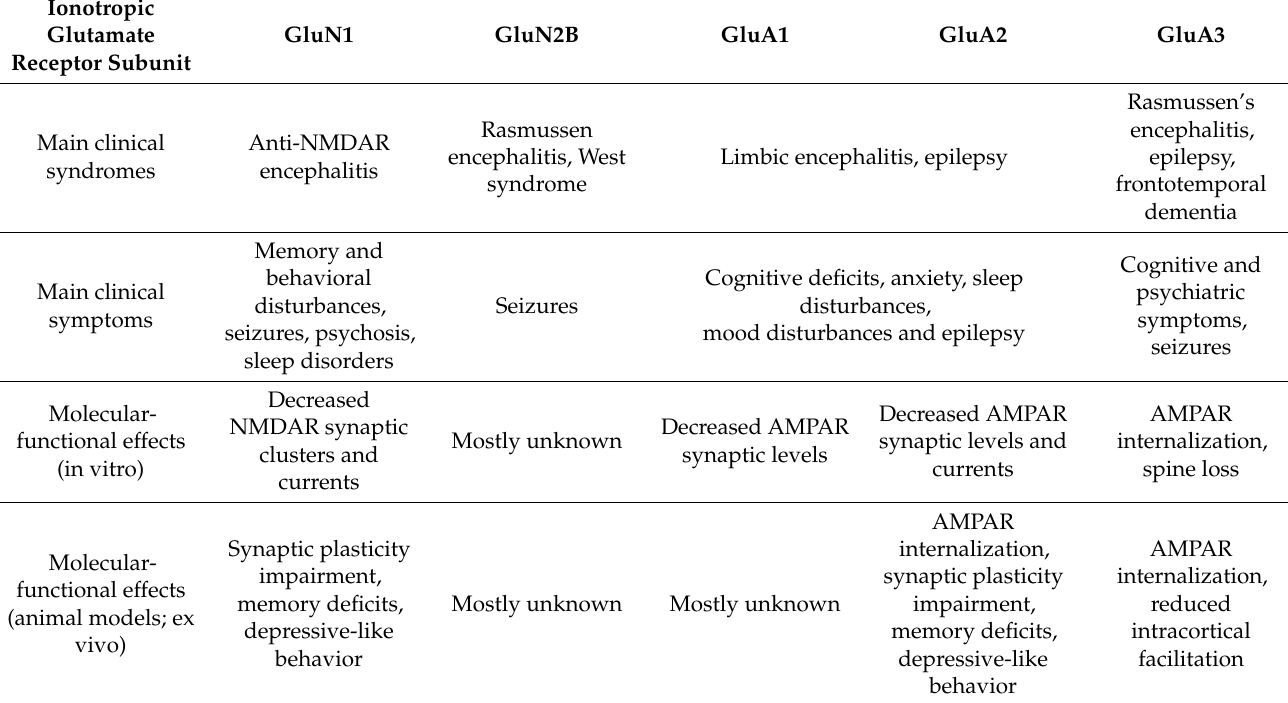
Table 1. Clinical and preclinical effects of NMDAR and AMPAR